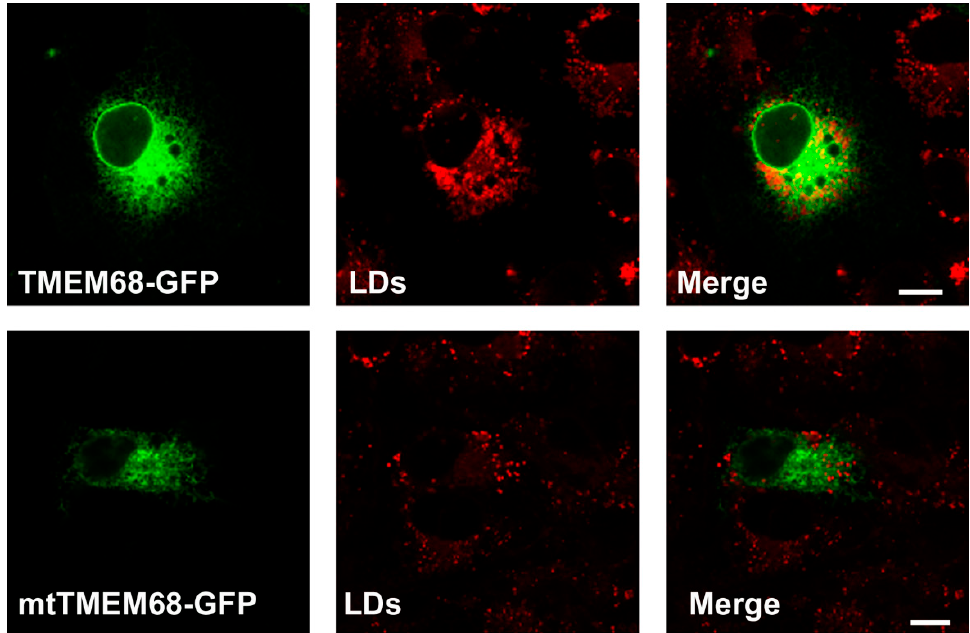
Figure 3. TMEM68 expression increases LDs content. MCF-7 cells were transfected with TMEM68- GFP and mtTMEM68-GFP, respectively, for 36 h, and then incubated with 0.2 mM OA for 12 h to induce LD formation. LDs were stained with HSC LipidTOX TM Deep Red, and images were acquired by confocal fluorescence microscopy. Figures are representative of at least three experiments. Scale bars = 10 μ m.